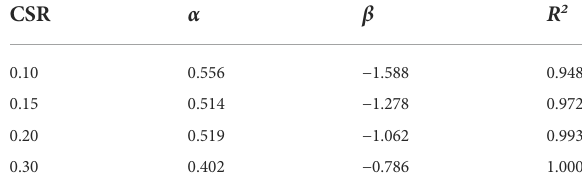
TABLE 5 Fitting parameters of Eq.